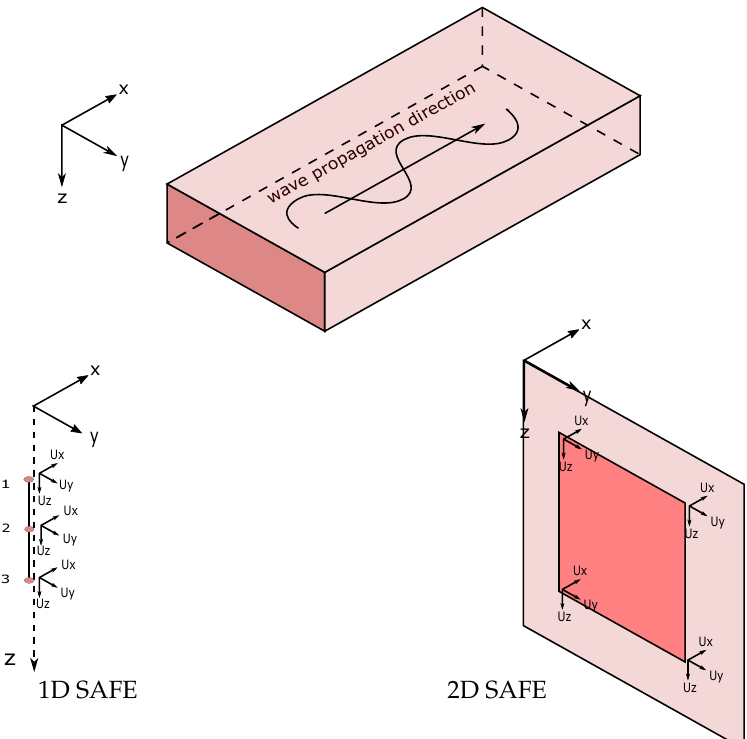
Figure 3. 1D and 2D element with three displacement DOFs at each node in the SAFE